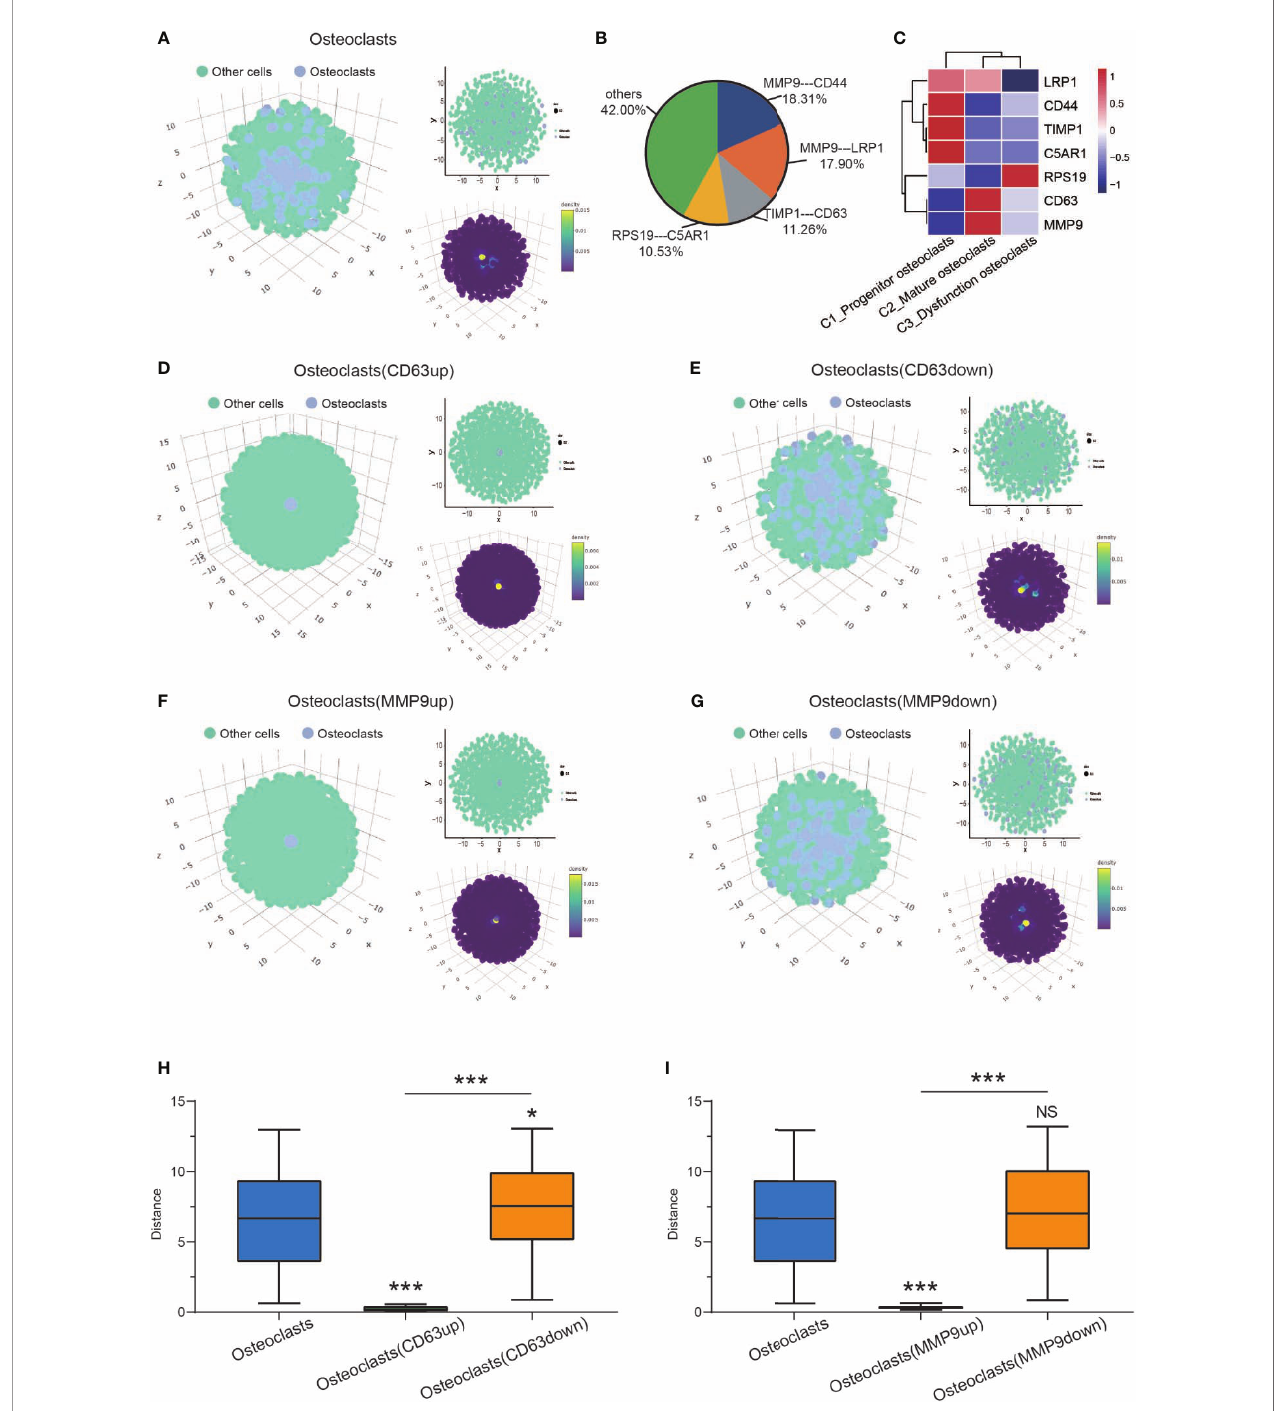
FIGURE 4 | CSOmap revealing osteoclast spatial information. (A) Global (left, lower right) and cross-sectional (upper right) views of the spatial information of osteoclasts and other cells. (B) Contributions of all ligand-receptor genes to the interactions between osteoclasts. (C) Heatmap of the 4 pairs of ligand receptors: (MMP9-CD44, MMP9-LRP1, TIMP1-CD63, RPS19-C5AR1). (D, E) Global (left, lower right) and cross-sectional (upper right) views of the spatial information on osteoclasts and other cells after the overexpression and knockdown of CD63. (F, G) Global (left, lower right) and cross-sectional (upper right) views of the spatial information of osteoclasts and other cells after the overexpression and knockdown of MMP9. (H) The distance of osteoclasts (normal control/CD63up/down) to the center (*P<0.05, ***P < 0.001). (I) The distance of osteoclasts (normal control/CD63up/down) to the center (***P < 0.001; NS, No statistical signi fi cance). CSOmap, Cellular Spatial Organization